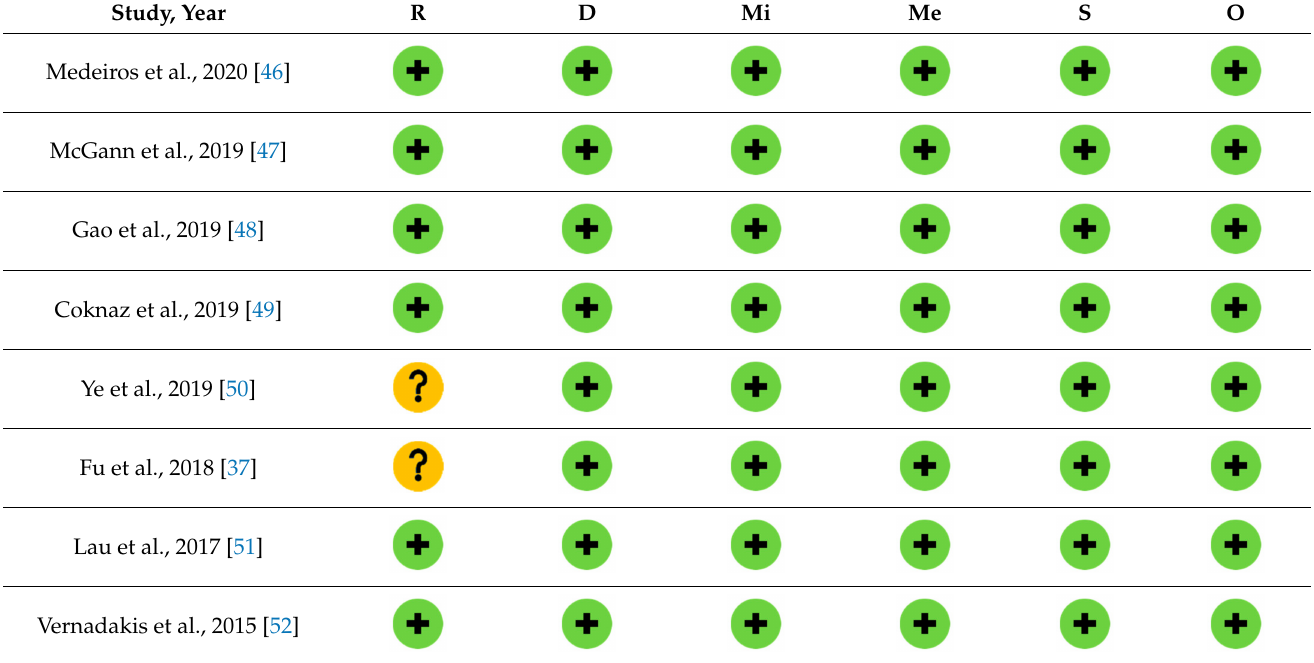
Table 1. Quality assessment of randomized controlled